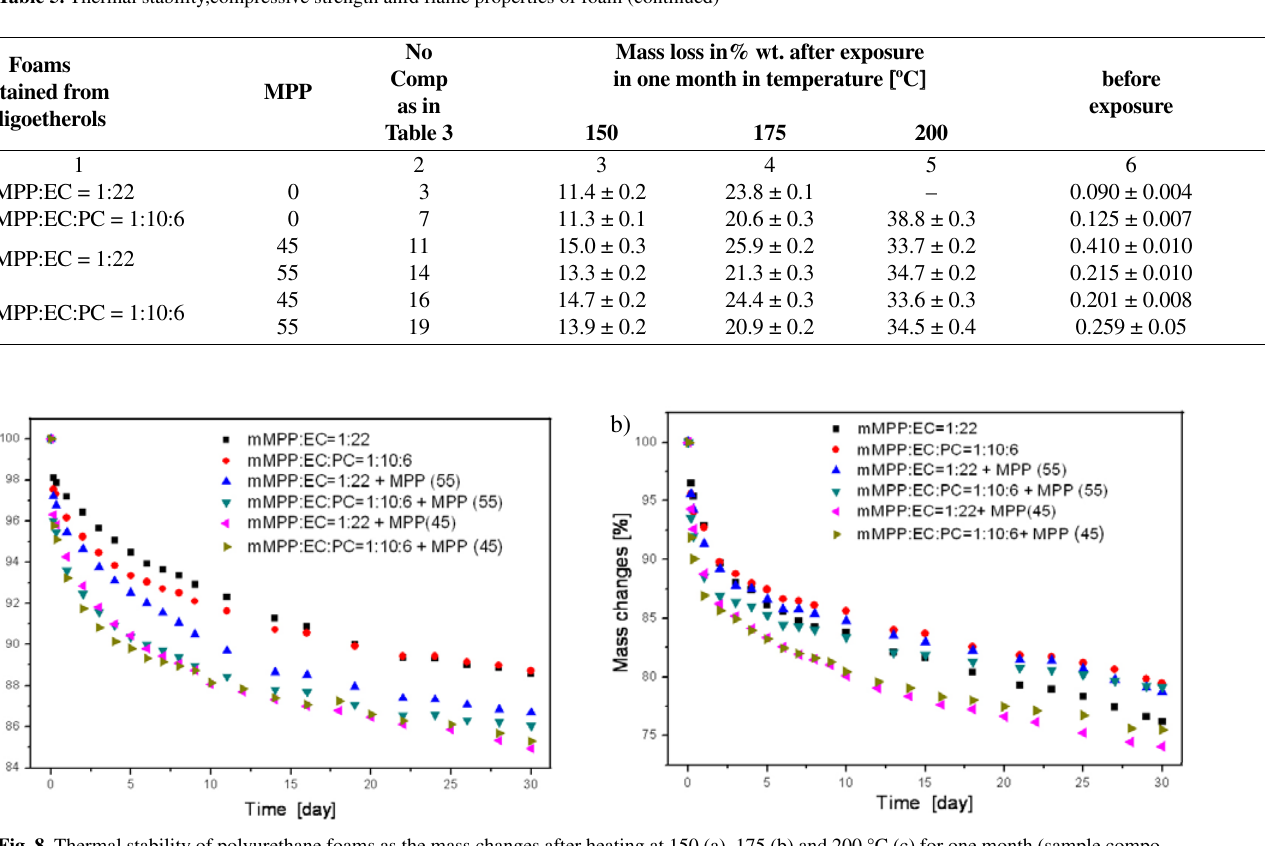
Fig. 8. Thermal stability of polyurethane foams as the mass changes after heating at 150 (a), 175 (b) and 200 °C (c) for one month (sample compo- sition is given in insert)